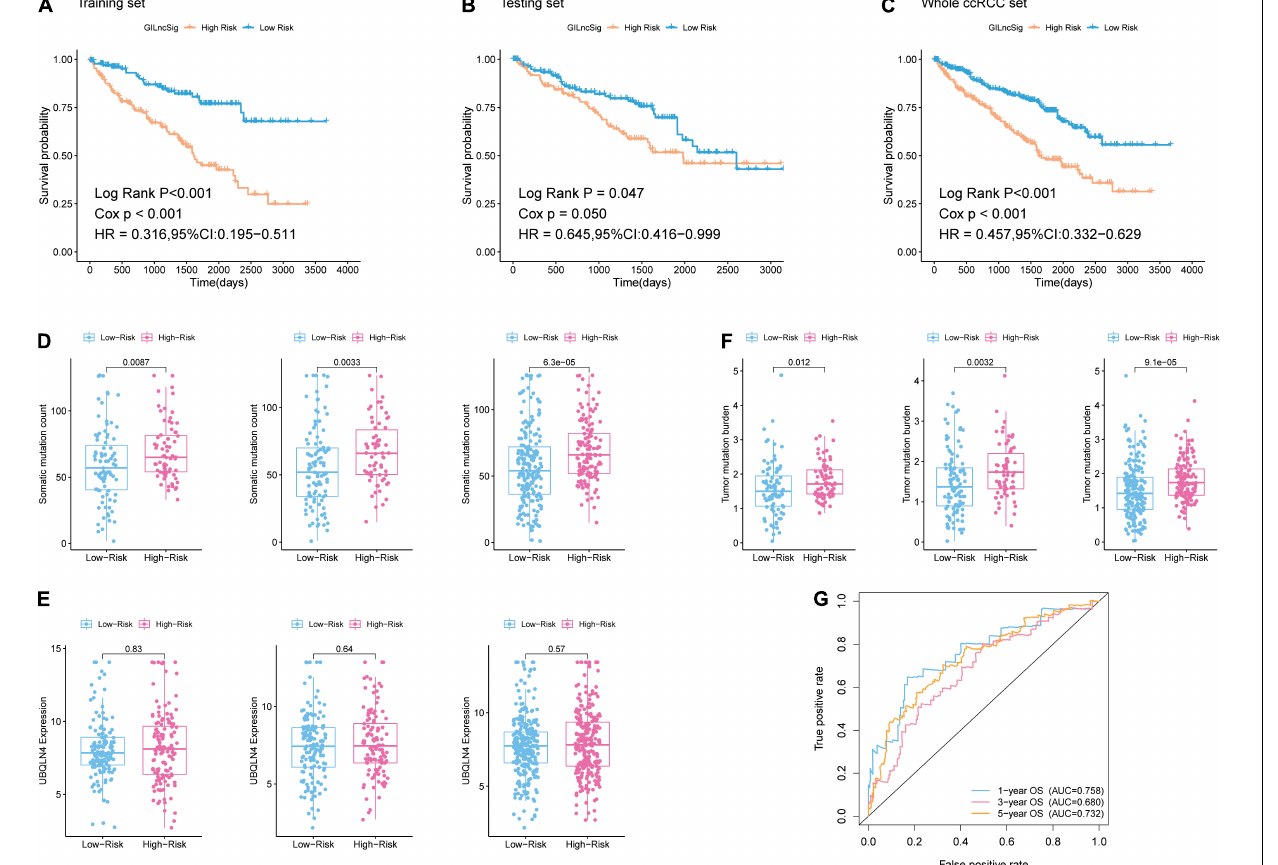
Frontiers in Genetics |